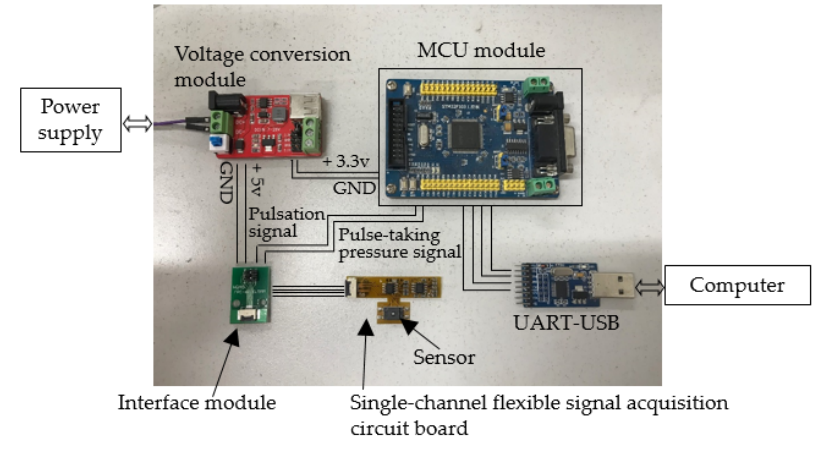
Figure 3. Signal acquisition and processing devices.